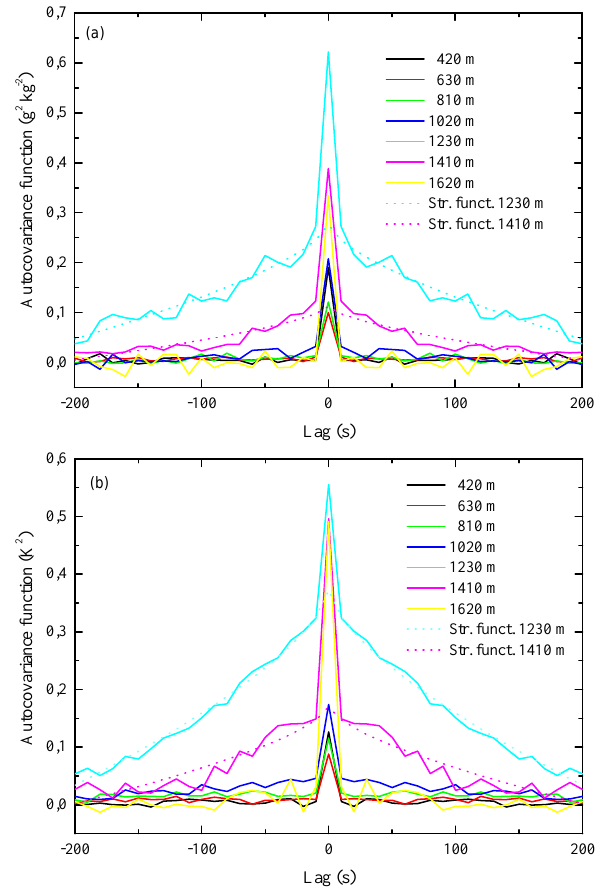
Figure 8. Autocovariance functions obtained from the measured water vapour mixing ratio (a) and temperature (b) fluctuations in the same time interval considered in Fig. 4. Autocovariance functions are displayed for the height levels between 400 and 1600ma.g.l., i.e. 0.3 to 1.25 z i , for lags from − 200 to